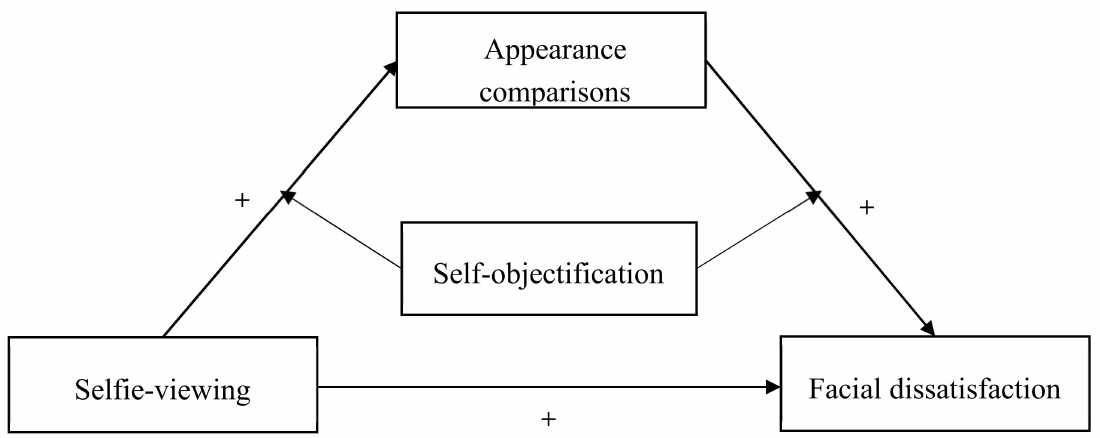
Figure 1. The proposed moderated mediation